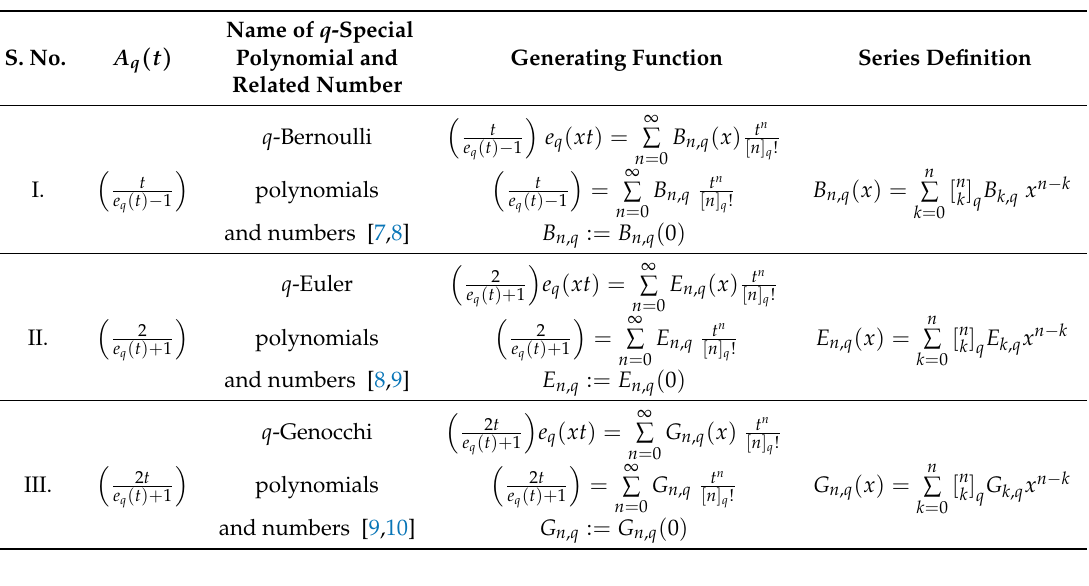
Table 1. Members related to q -Appell family.